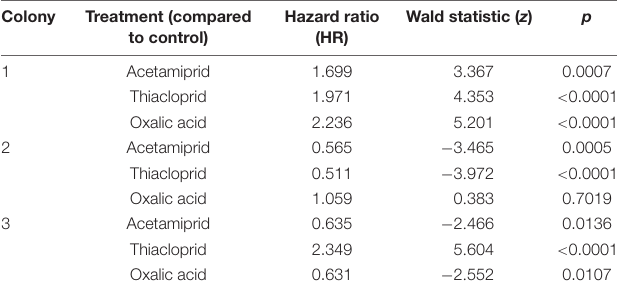
Treatment had a significant effect (LM: F 3 , 177 = 5.16, p = 0.0019),